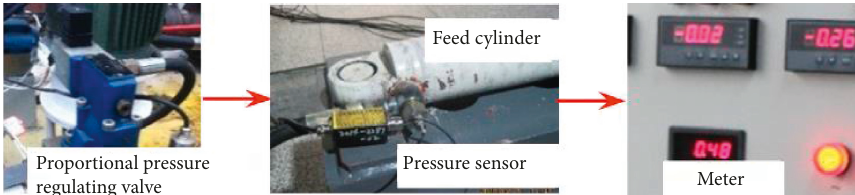
Figure 6: The adjustment and testing of the feed force.